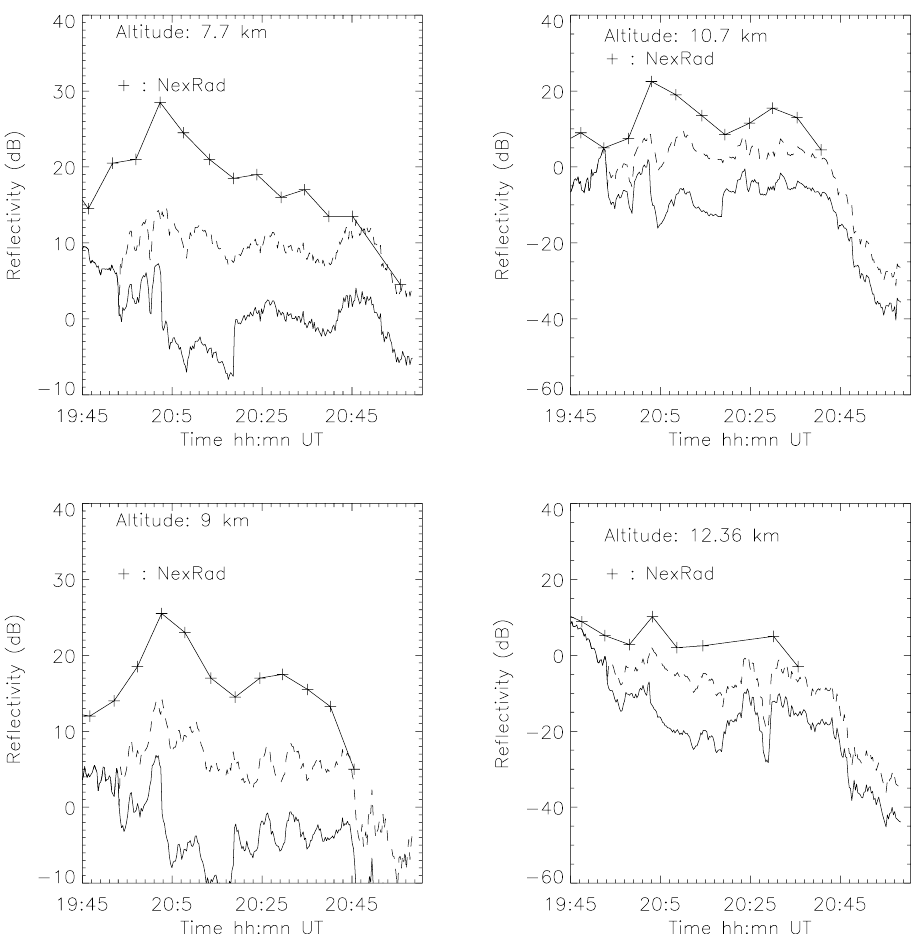
Fig. 7. Time evolution of the reflectivity of UHF and NexRad radars at different altitudes on 15 October 1998. The UHF radar reflectivity is averaged over 5 gates, i.e. 1.500km, in order to be compared to the NexRad data whose beamwidth is 1.3km.